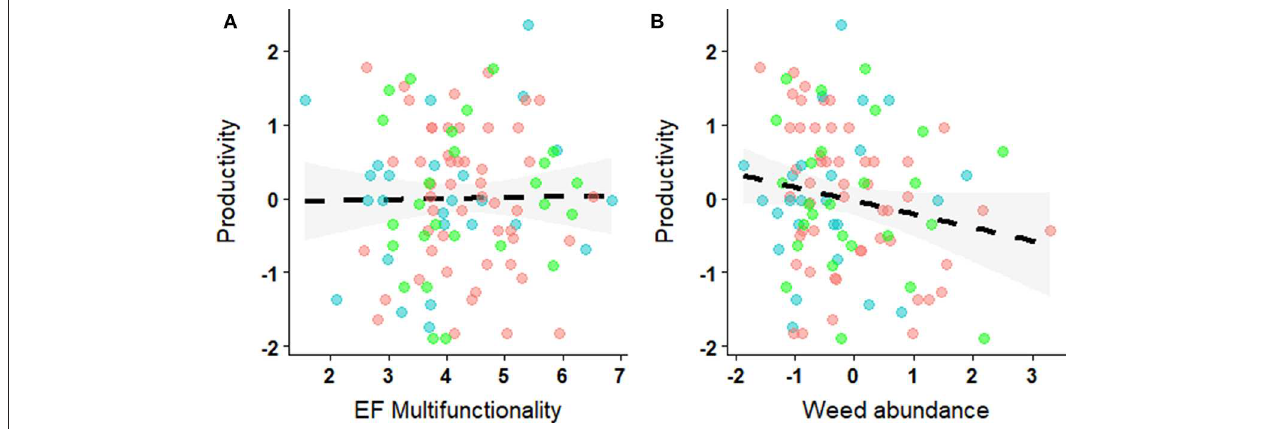
FIGURE 6 | Relationship between productivity (standardized) and (A) EF-multifunctionality or (B) weed abundance. Colors indicate the different crop type (cereals in red, oilseed rape in green and haylands in blue) and the shade area the 95% confidence interval.